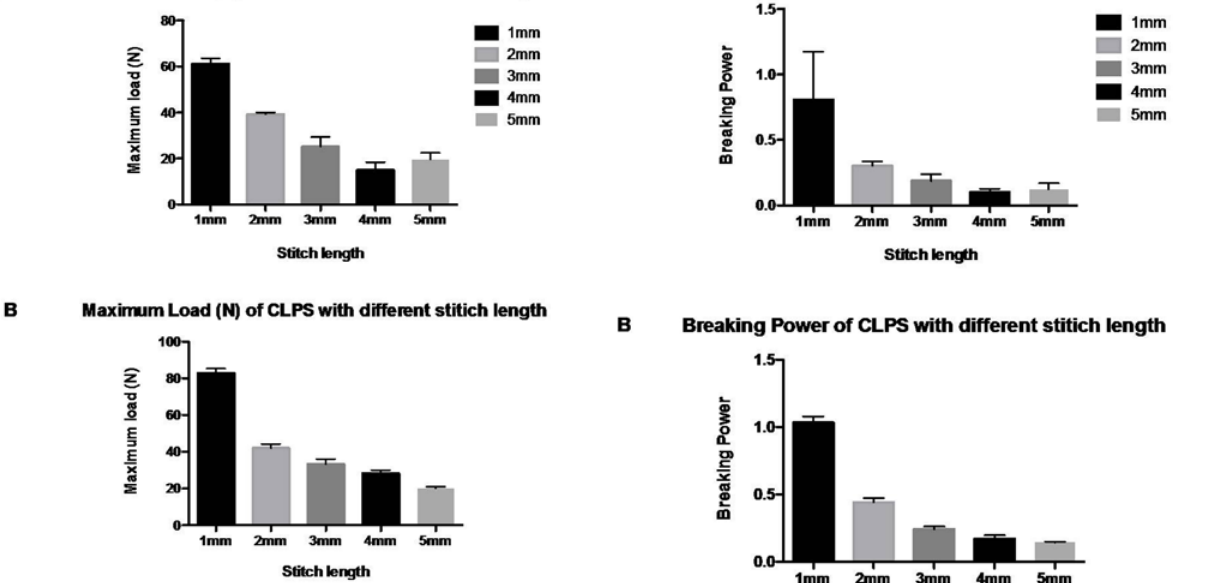
Figure 2: Comparison of Maximum load (N) of CRPS (A) with CLPS (B) with different stitch length.